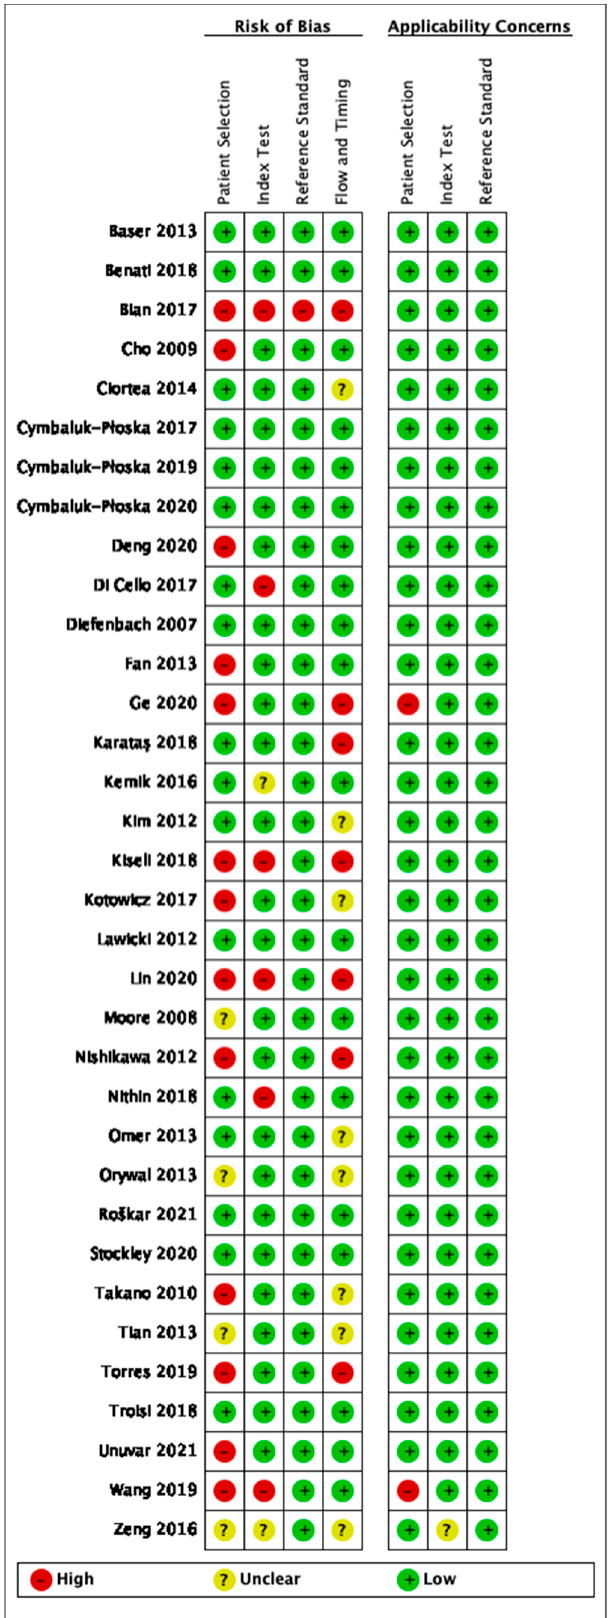
Figure 3. Risk of bias and applicability concerns summary: review authors’ judgements about each domain for proteomic studies.